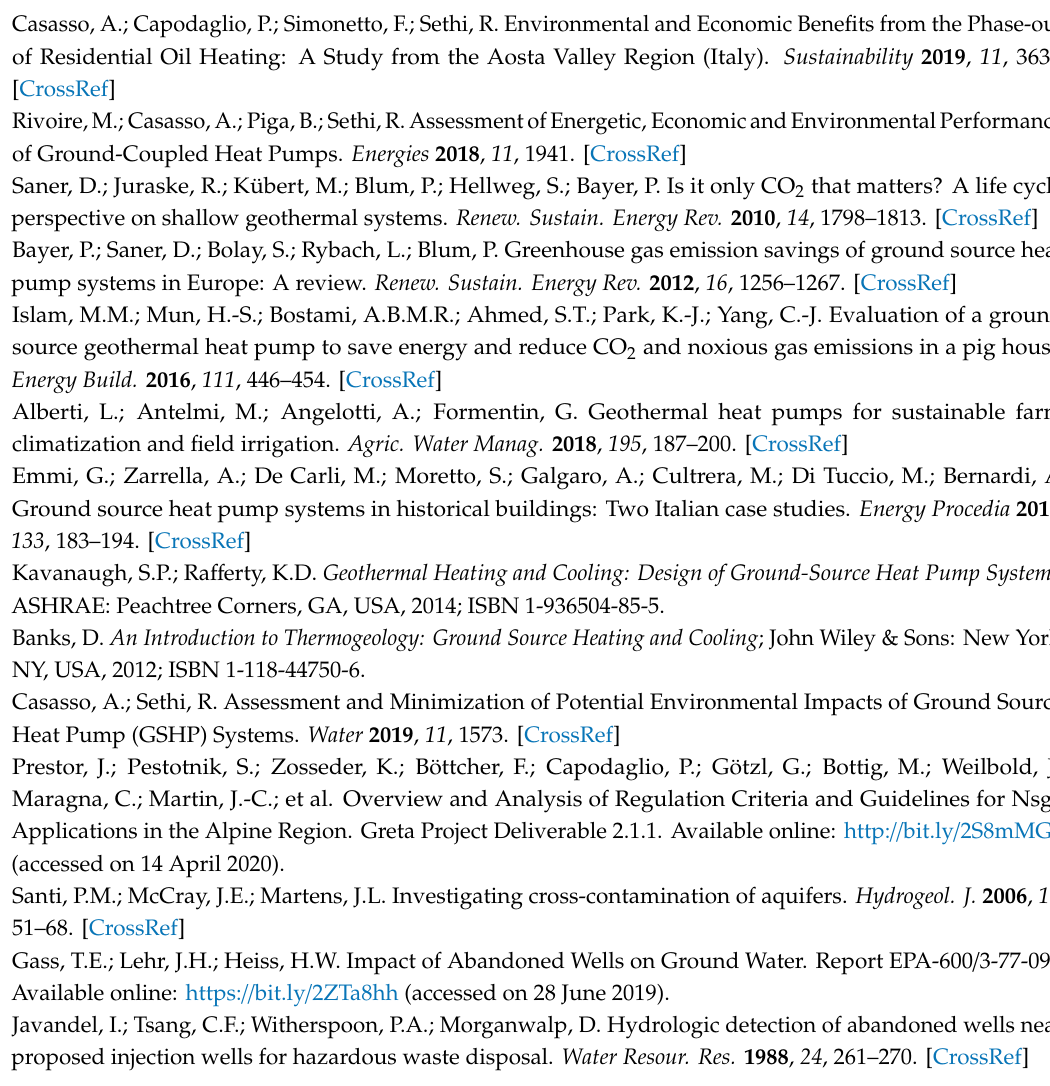
Figure S1. E ff ect of the hydraulic conductivity of the deep aquifer on the contaminant concentrations at the top of the deep aquifer, 200 m downstream the borehole outlet; Figure S2. E ff ect of the contaminant longitudinal dispersivity value α L . The transverse dispersivity is set to to α T = 0.1 α L for each case; Figure S3. E ff ect of vertical resolution: comparison of the time series of contaminant concentrations at di ff erent distances downstream the borehole outlet (40, 80, 120, 160 and 200 m) with the “standard” resolution (layer thickness of 5 m for aquifers and 1 m for the aquitard) and the doubled resolution (layer thickness of 2.5 m for aquifers and 0.5 m for the aquitard); Figure S4. Position of Ciri è , the location of the two monitored wells examined, in North-Western Italy; Figure S5. Monitoring wells in Ciri è , screened in the shallow aquifer (red line) and in the deep aquifer (light blue